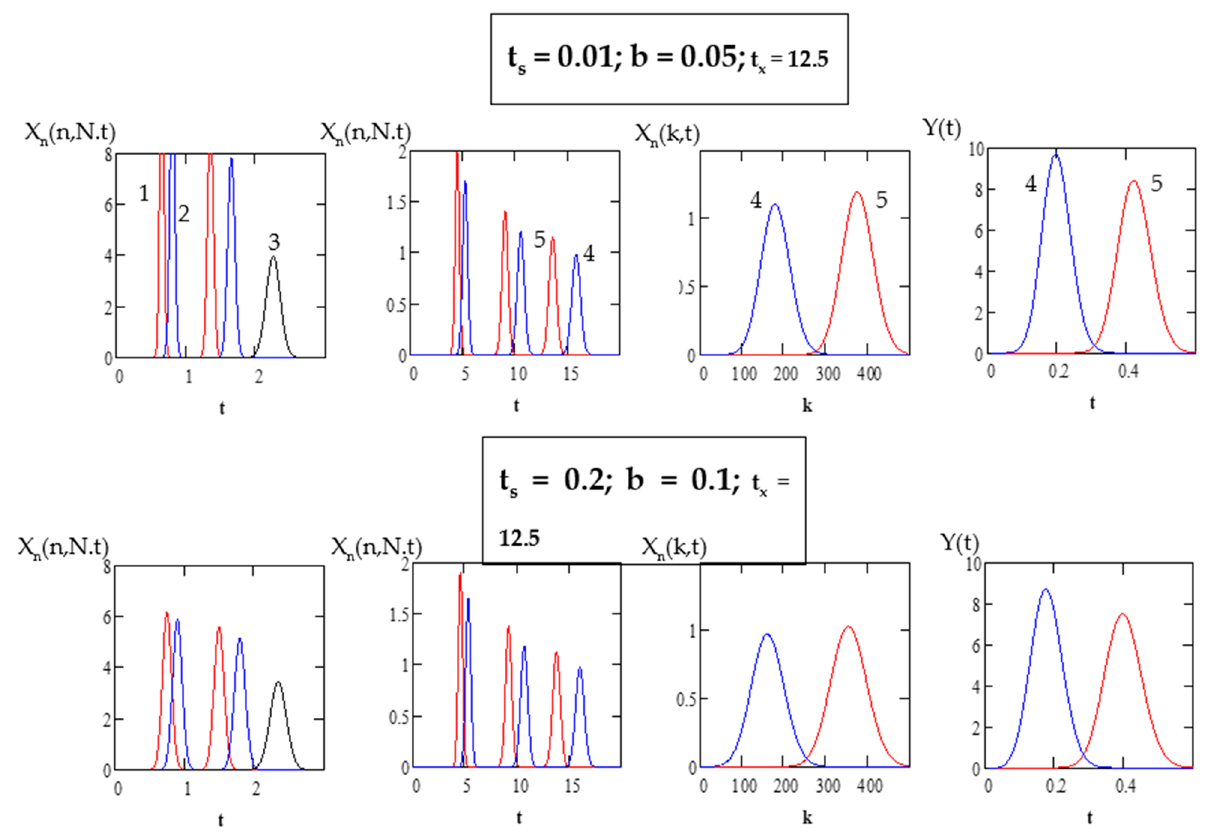
Figure 5. Simulation of the separation of the mixture containing five compounds ( K D 1 = 0.3, K D 2 = 0.6, K D 3 = 3.5, K D 4 = 8, K D 5 = 9.5) on the closed-loop setup with N = 500, N ec = 200, and S f = 0.5.